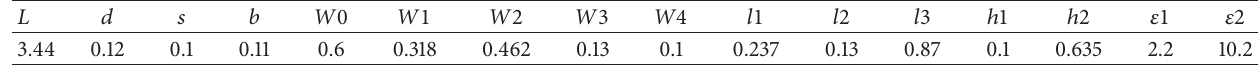
Table 1: Values of design parameters (all in millimetres).